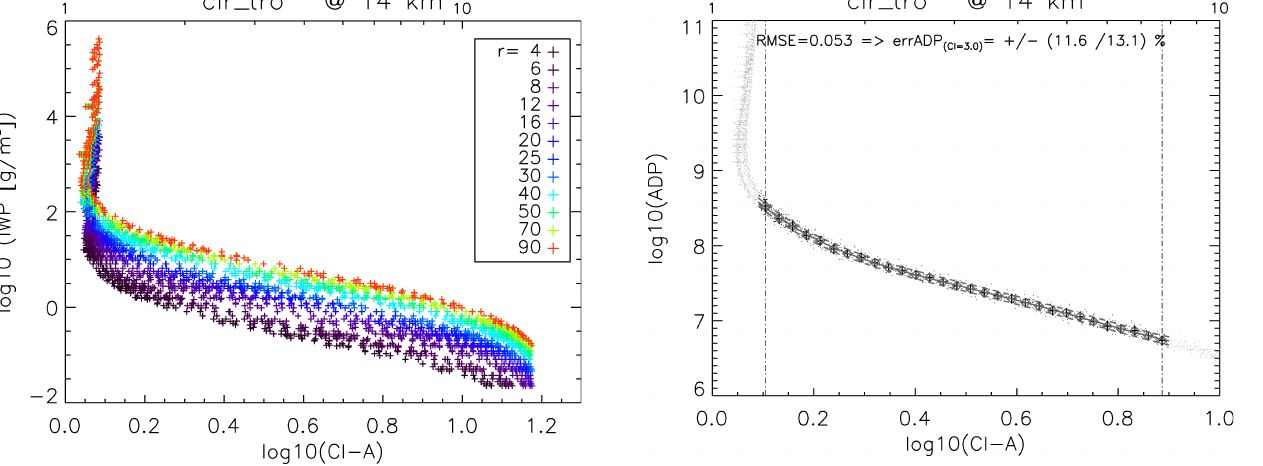
Fig. 5. Correlation diagram between CI A and the cirrus IWP (both parameters in log 10 space) for tropical CSDB spectra at 14km alti- tude. The varying effective radius in units of µm is colour coded.